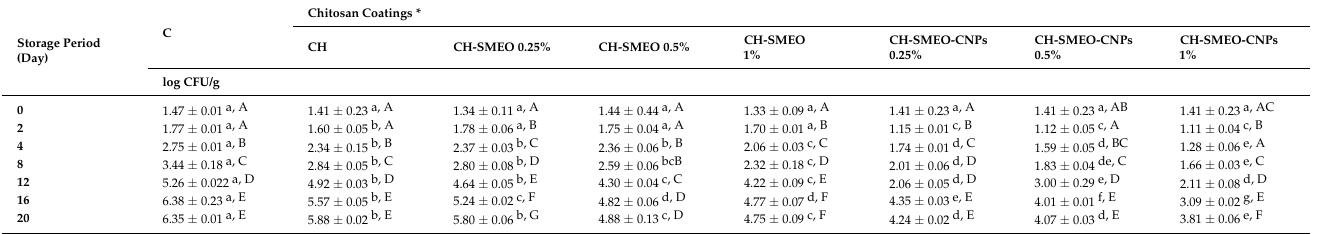
Table 5. Effect of the addition of chitosan coatings and chitosan-based nanoparticles enriched with Satureja montana L. essential oil on the change in the number of lactic acid bacteria (LAB) in beef samples during